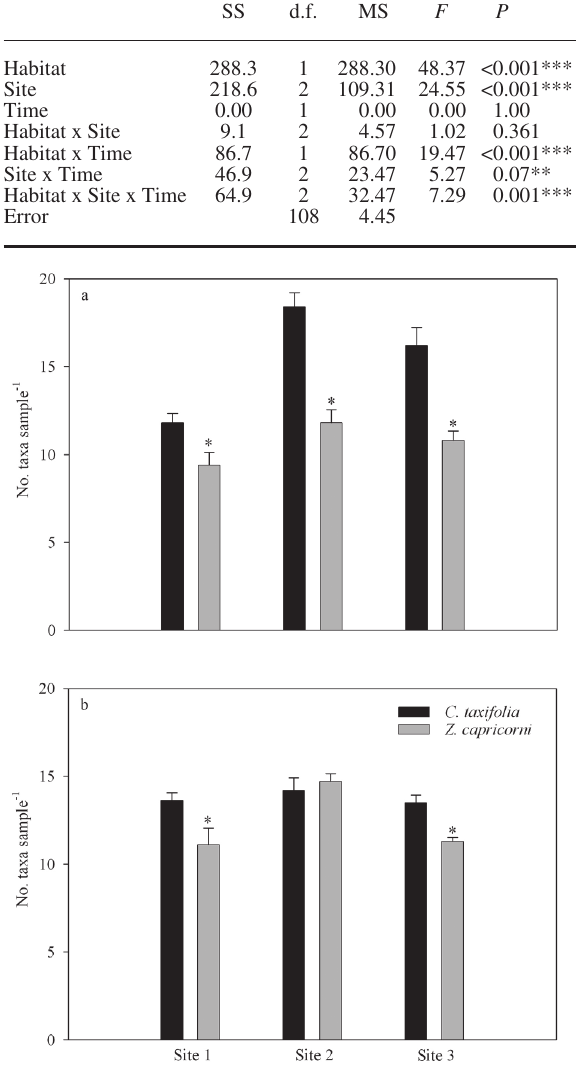
Fig . 2. – Mean No. of taxa recorded on fronds of Caulerpa taxifo- lia and leaves of Zostera capricorni at the three study sites in the September (a) and (b) October sampling. In SNK, significant differ- ences among habitats at each site are indicated with asterisks. Error bars are